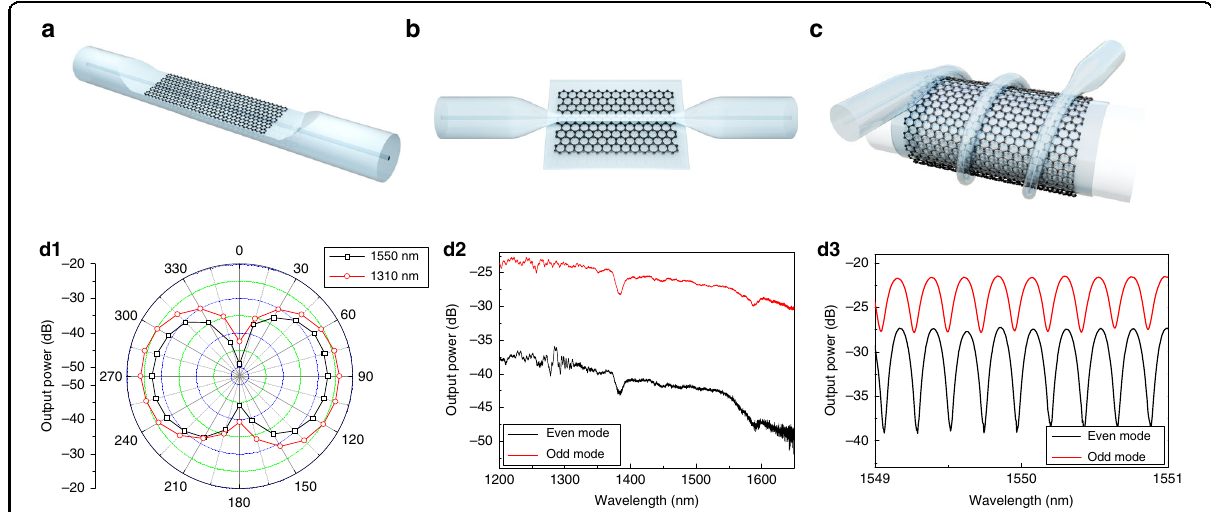
Fig. 3 Polarimetric fi ber devices with graphene. a D-shaped fi ber laminated with graphene. b Optical micro fi ber (MF) on graphene-substrate. c Stereo MF-graphene structure with adjacent coil coupled or isolated. Fiber polarizer characterizations in stereo MF-graphene devices by two-coil structure ( d1 – d2 ) 47 . d3 Transmission spectra of the MF-graphene coil-resonator for two orthogonal modes 47 . d1 – d3 Reproduced from ref. 47 with the permission of OSA